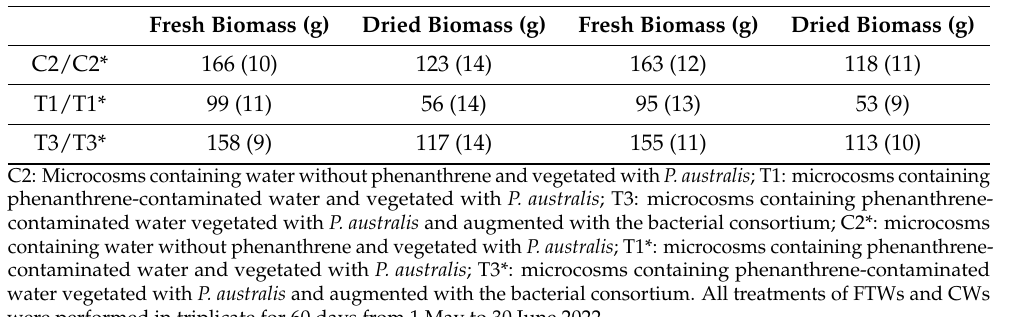
Table 3. Fresh (FW) and dried biomass (DW) of Phragmites australis in response to phenanthrene contamination and bacterial augmentation in FTWs and CWs. Constructed Wetlands Floating Treatment Wetlands